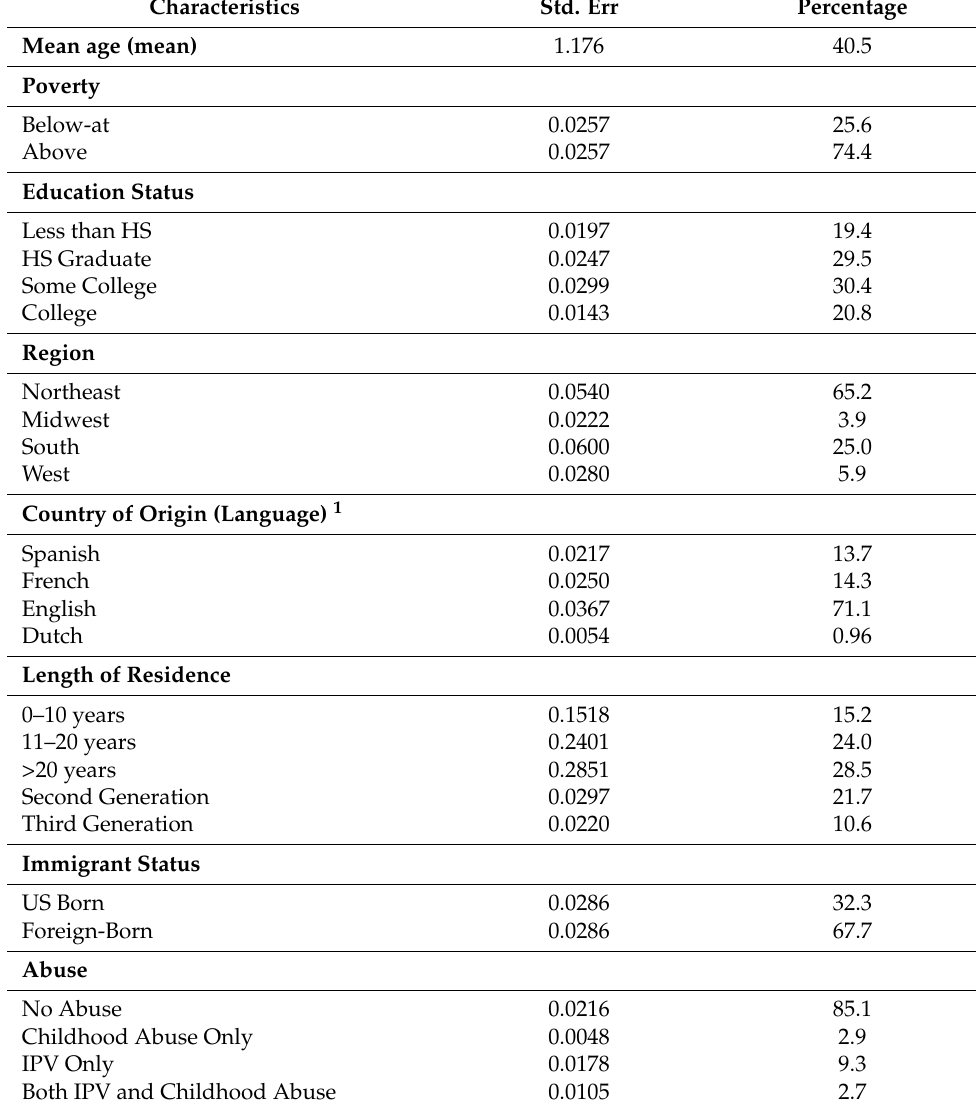
Table 1. Sample Characteristics (N = 961).